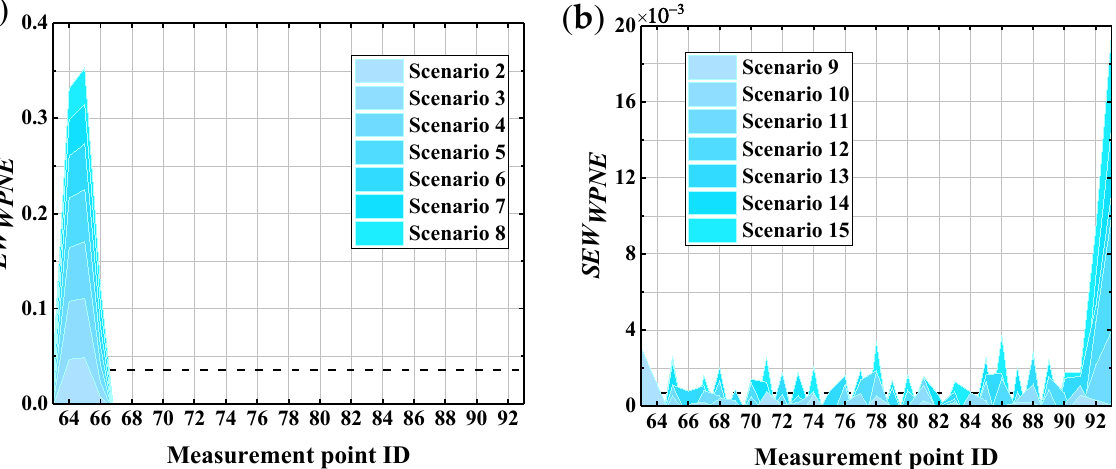
Figure 19. The identification results of the damage indexes when SNR = 60 dB: ( a ) EW WPNE ; ( b ) SEW WPNE .